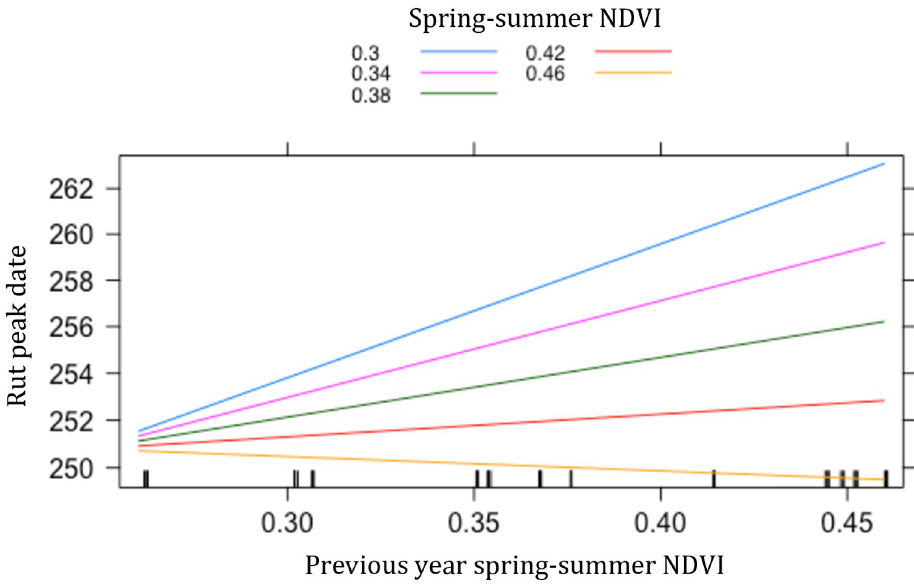
Fig 2. Effect of the interaction between the spring-summer NDVI and the NDVI of the previous-year spring- summer on the rut peak date, from model 2. Figure shows predicted relationships between previous-year NDVI and the rut peak date for different values of spring-summer NDVI in the current